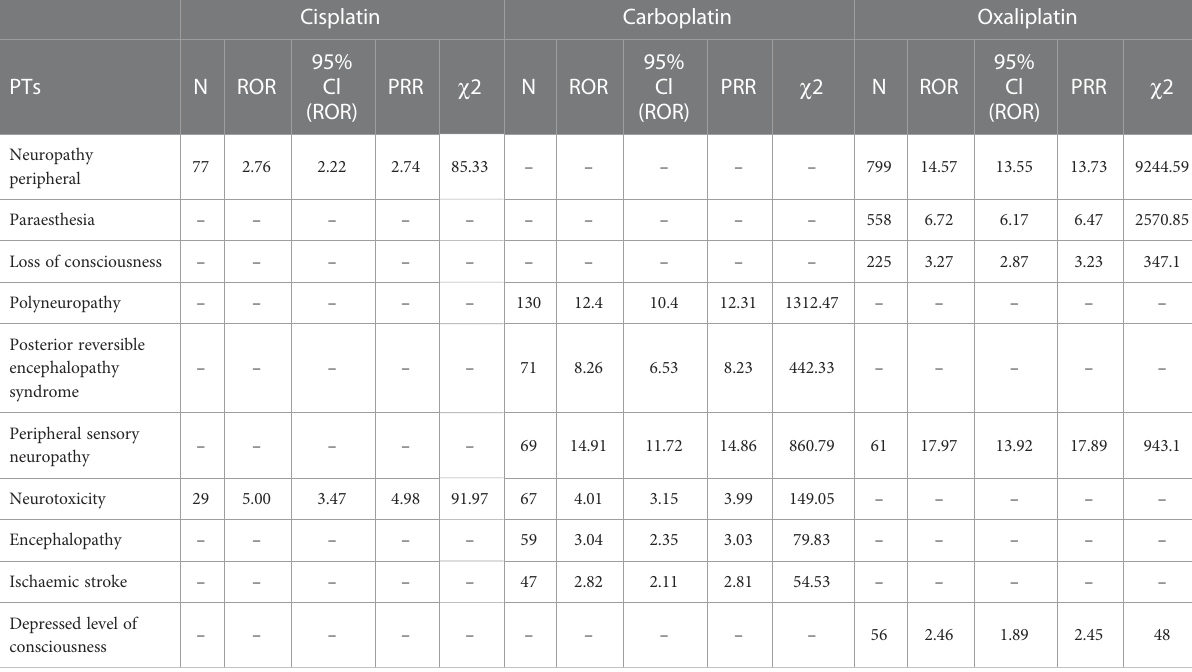
TABLE 4 Various types of nervous system disorder-related adverse events of Cisplatin, Carboplatin and Oxaliplatin. Cisplatin Carboplatin